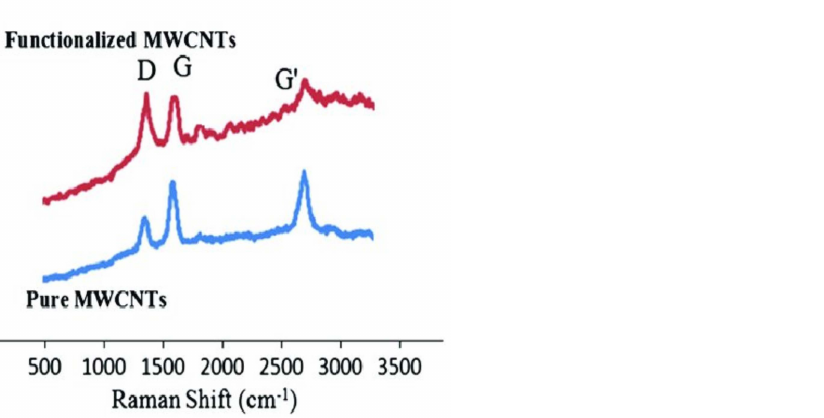
Figure 2. Raman spectroscopy of reference and functional MWCNTs showing –OH and –CO groups attached after acid treatment.